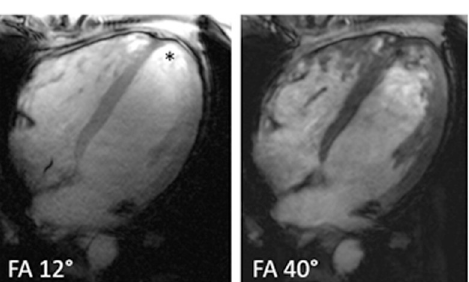
Fig 4. Image quality in a single volunteer depending on the chosen flip angle. Left a flip angle of 12˚ was chosen, right a flip angle of 40˚ was used. The image contrast between the myocardium and the blood volume is better on the right side, however, the trabecula and myocardial borders appear more blurred. With a flip angle of 12˚, an apical signal overshoot is visible (Asterisk). The overall score for the right ventricle was rated with a score of 7.33 for the diastolic and a score of 7.26 for the systolic phase. The left ventricle was rated with 6.71 for the diastolic and 7.24 for the systolic phase.